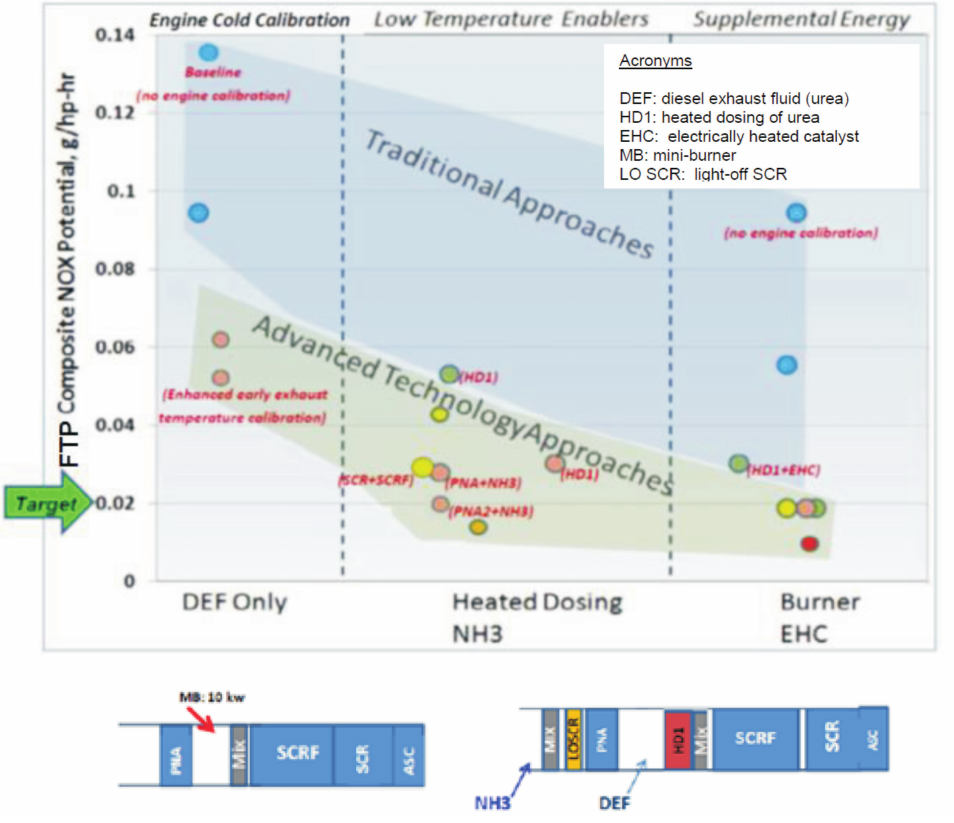
Fig. 7. Preliminary burner rig results and two HD systems delivering the lowest NO